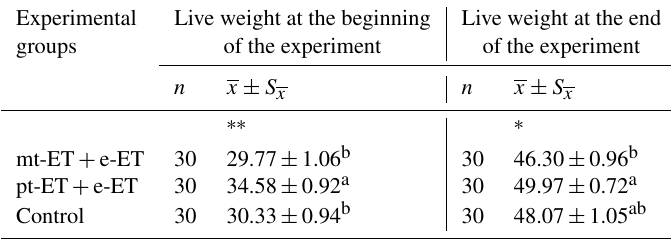
Table 1. Least-squares means ( ± SE) for the live weight of the lambs in the control and experimental groups (kg). Experimental Live weight at the beginning Live weight at the end groups of the experiment